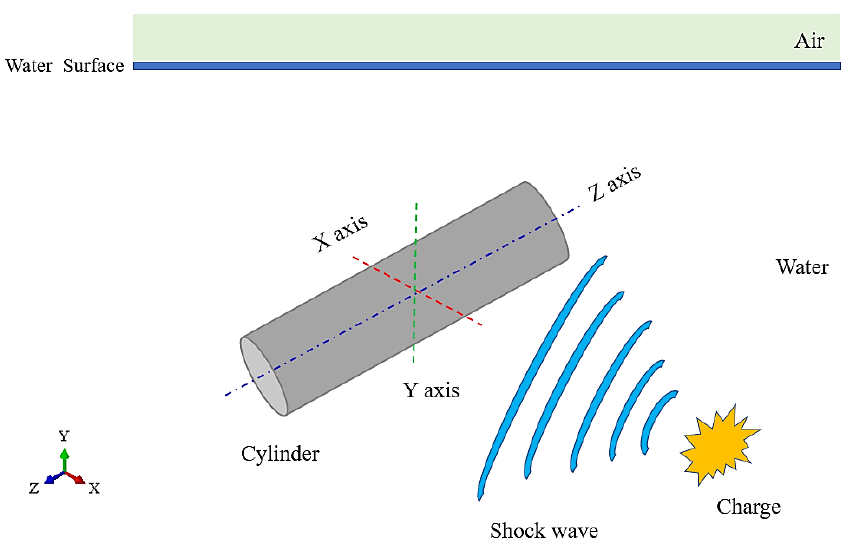
Figure 1. Schematic of physical model of